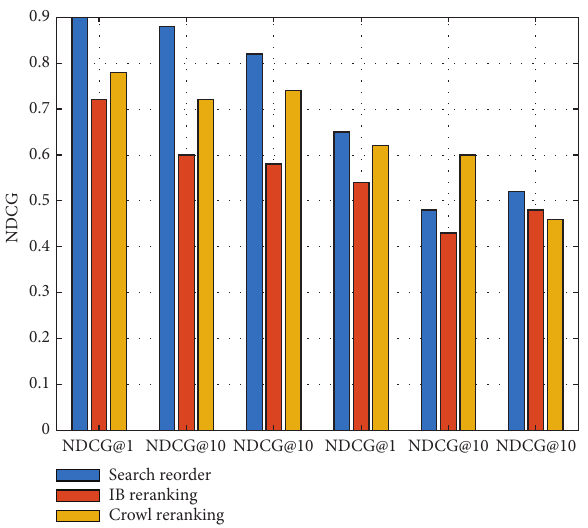
Figure 3: Comparison of reordering